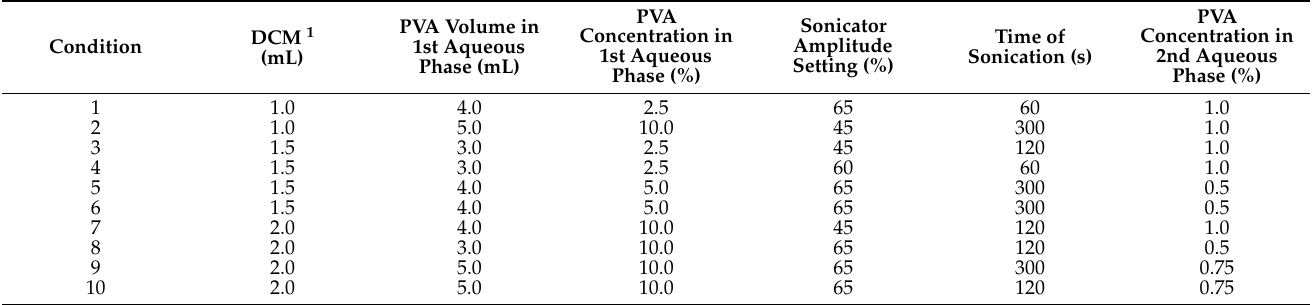
Table 1. Conditions evaluated for optimization of nanoparticle preparation.